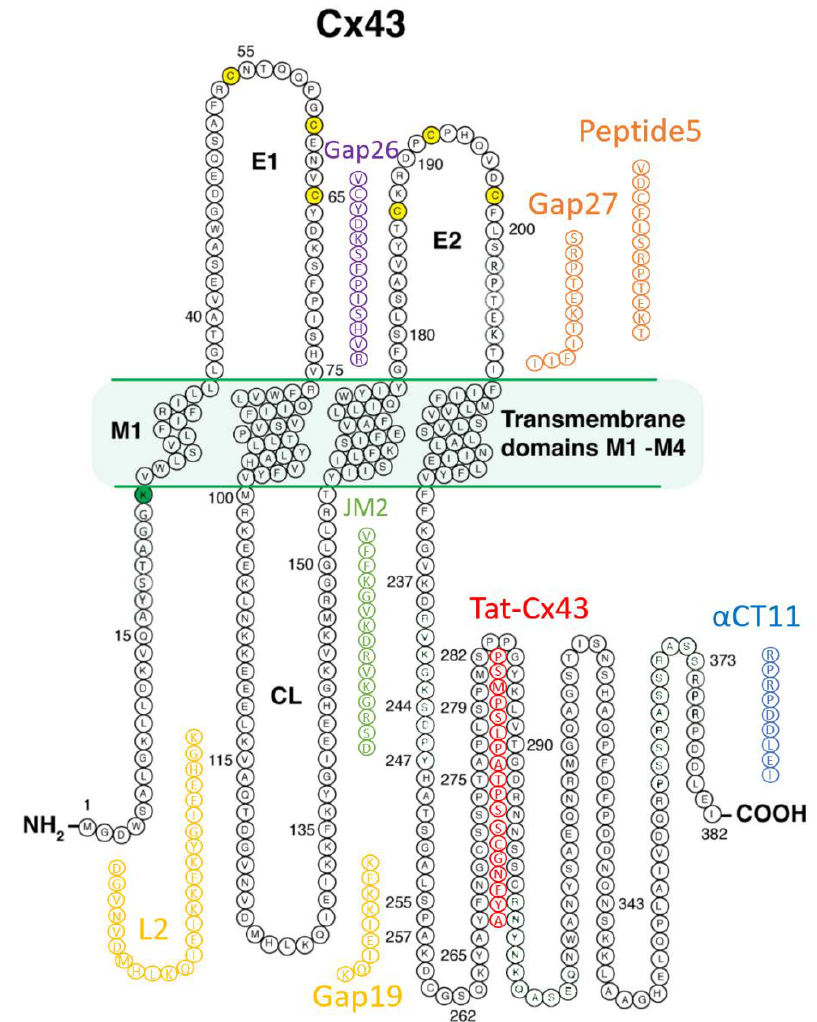
Figure 2 : Connexin-43 mimetic peptides discussed in this review Figure 2. Connexin-43 mimetic peptides discussed in this review. Table 1. Overview of Cx43 mimetic peptides and their currently known effects. Table 1. Overview of Cx43 mimetic peptides and their currently known